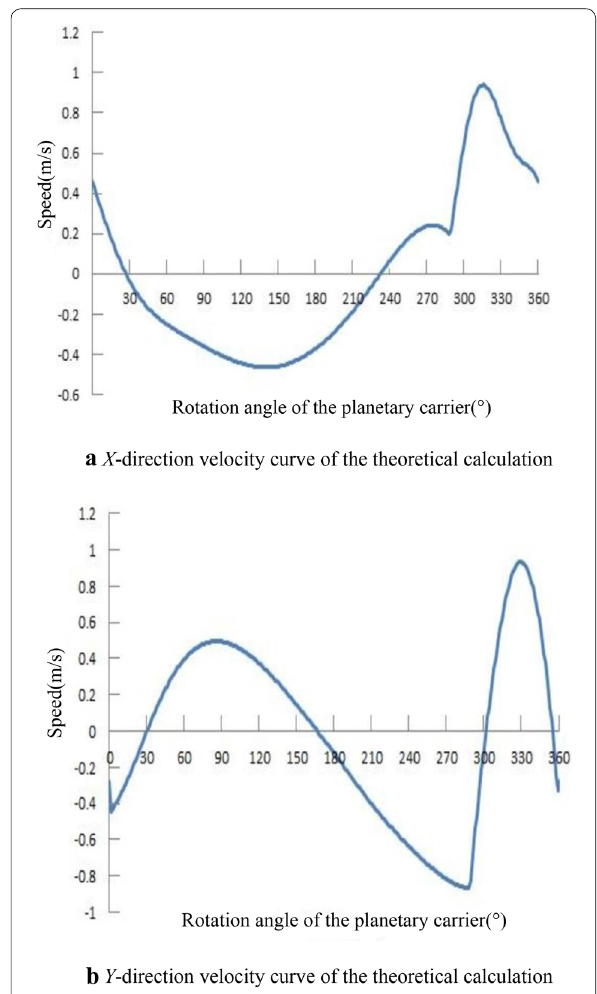
Figure 8 Theoretical velocity